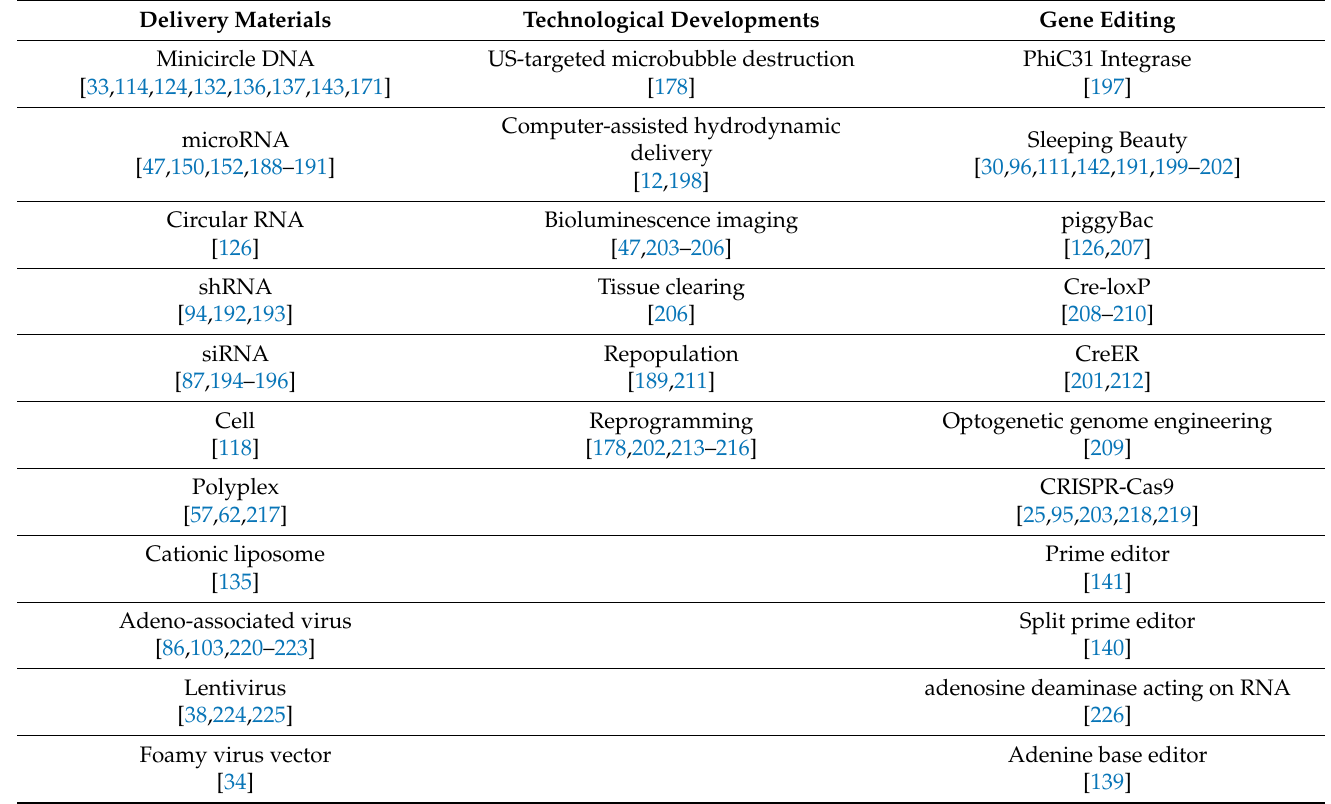
Table 3. Strategies/materials coupled with hydrodynamic